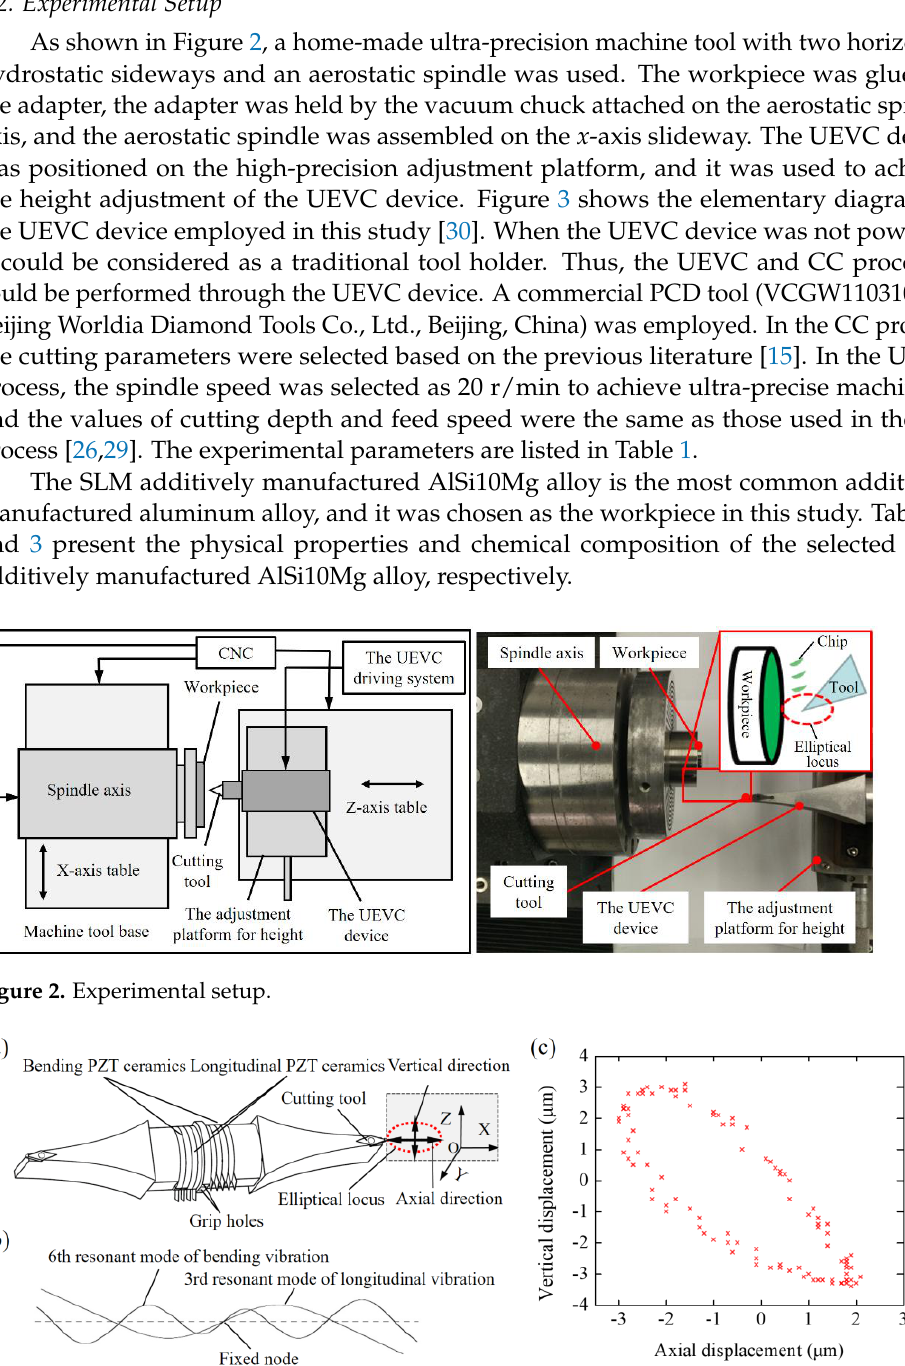
Figure 3. ( a ) A structural drawing of the UEVC device; ( b ) Vibration modes of UEVC device; ( c ) Vibration trajectory of tool tip. Table 1. Experimental conditions.